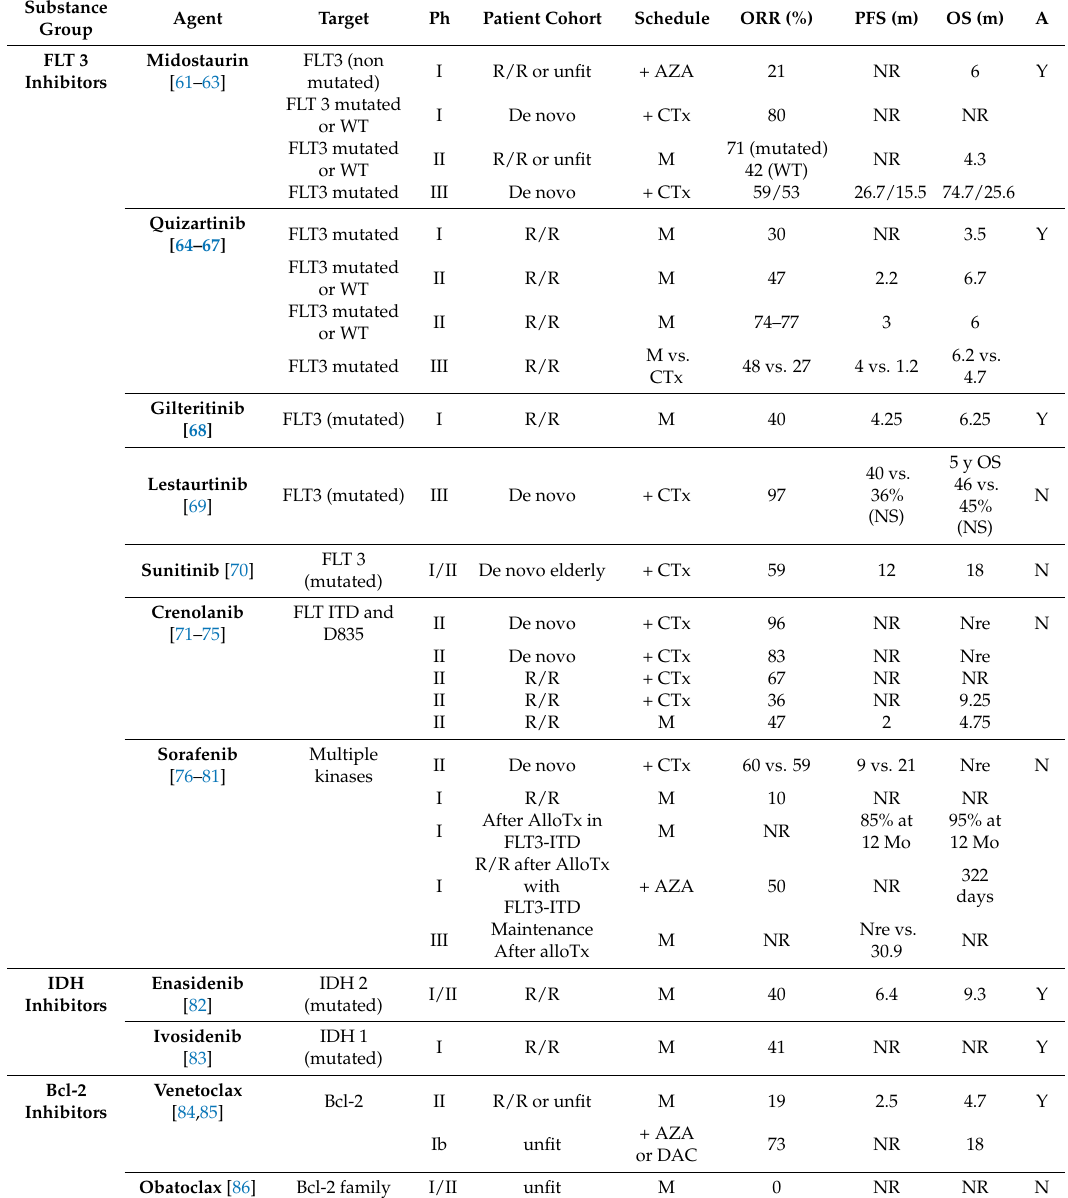
Table 3. Summary of relevant clinical trials with targeted agents in